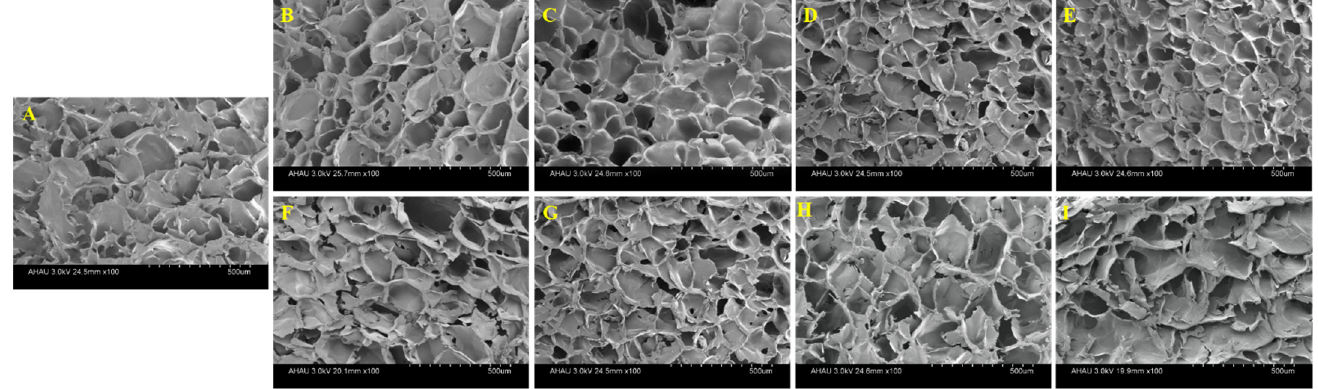
Figure 4. SEM images of different proportions of HPGRS and LAEGRS (0%, 1%, 3%, 5%, and 10%) blended with WS respectively.WS ( A ), HPGRS-WS ( B – E ), LAEGRS-WS ( F – I ).